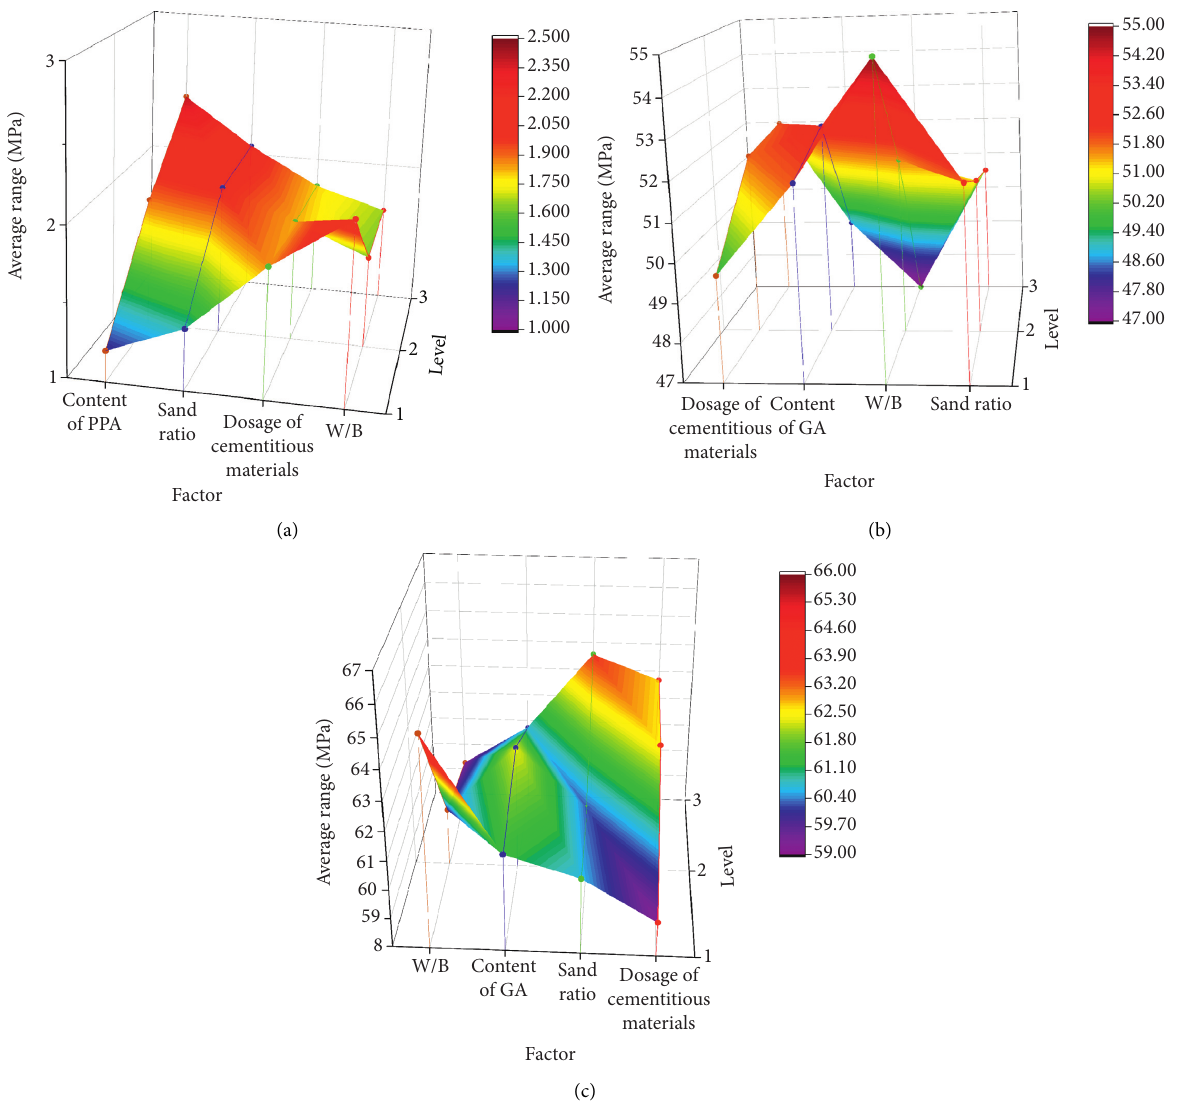
Figure 19: Diagram of mixing amount of water reducer and compressive strength of PPAC. (a) The dosage of water reducing agent range; (b) the 7-day compressive strength; (c) the 28-day compressive